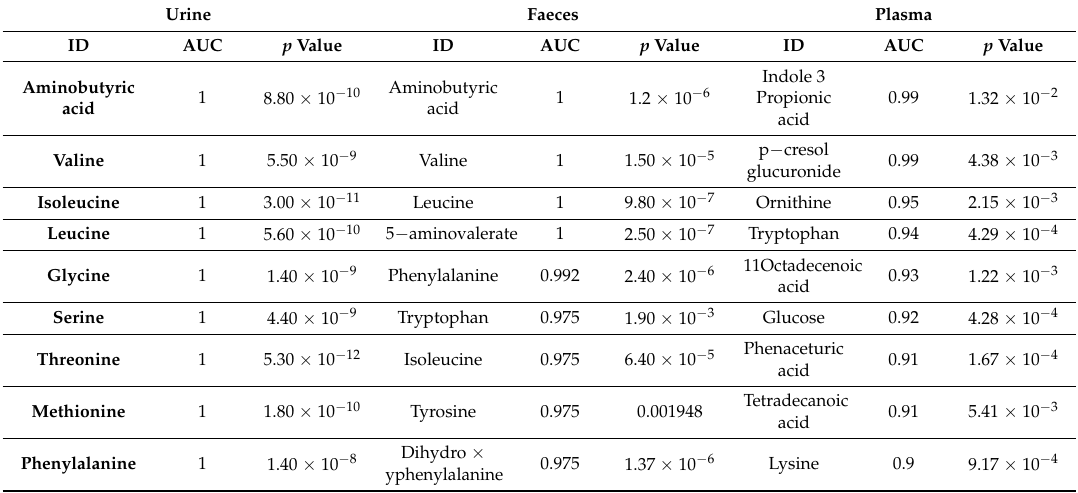
Table 6. AUROC analysis of metabolites in urine, faeces and plasma to distinguish between SLC6A19ko and SLC6A19wt